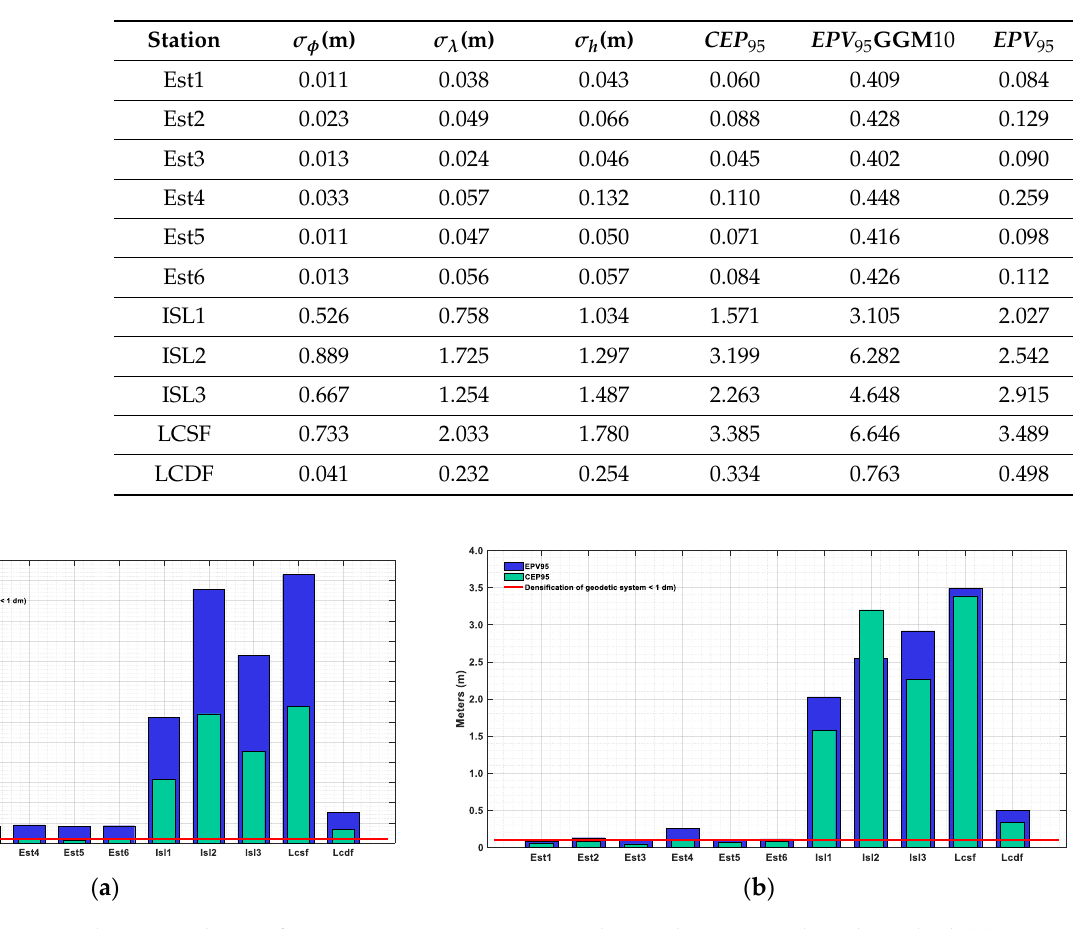
Table 7. Results of the CEP and EPV of the static relative method according to the INEGI technical standard. Station